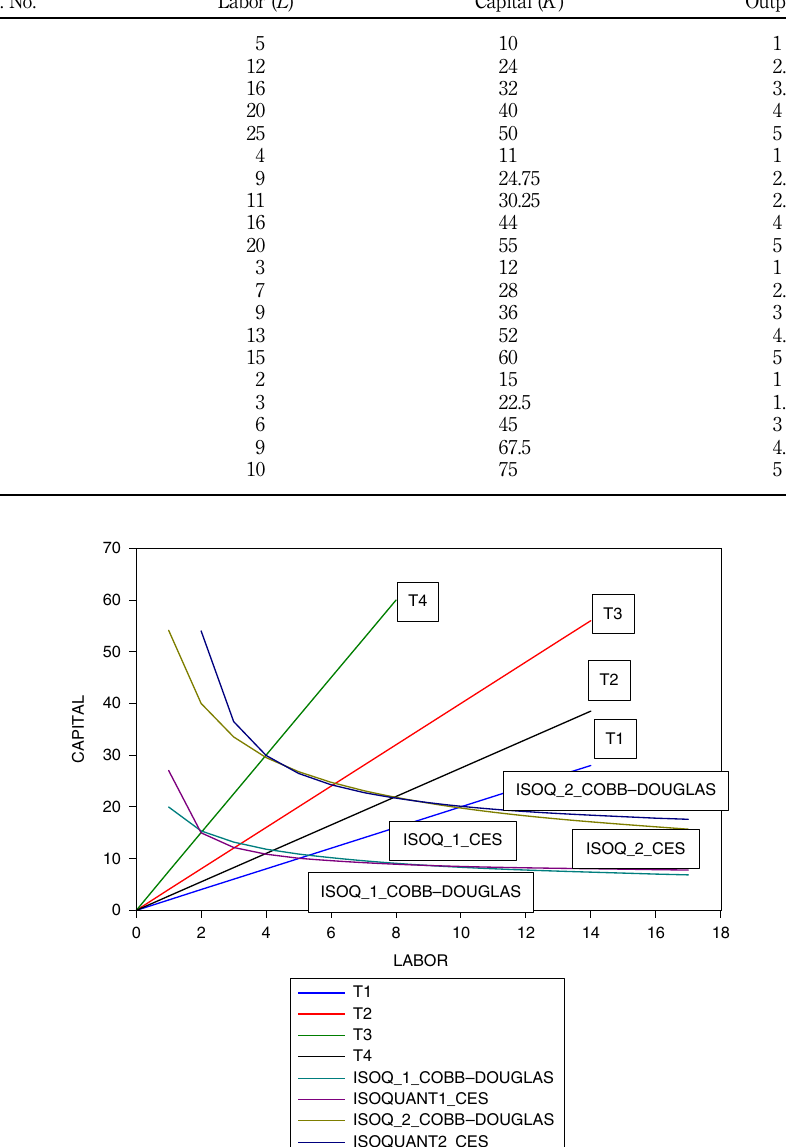
correspond to the same multiples of the capital and labor amounts keeping capital/labor ratios constant in each group to have a fixed-proportions production function. For example, in the first group (the first five observations), the capital-labor ratio is fixed, K / L ¼ 10/ 5 ¼ 24/12 ¼ 32/16 … 50/25 ¼ 2 and the output levels are 1, 2.4, 3.2, 4 and 5 units.